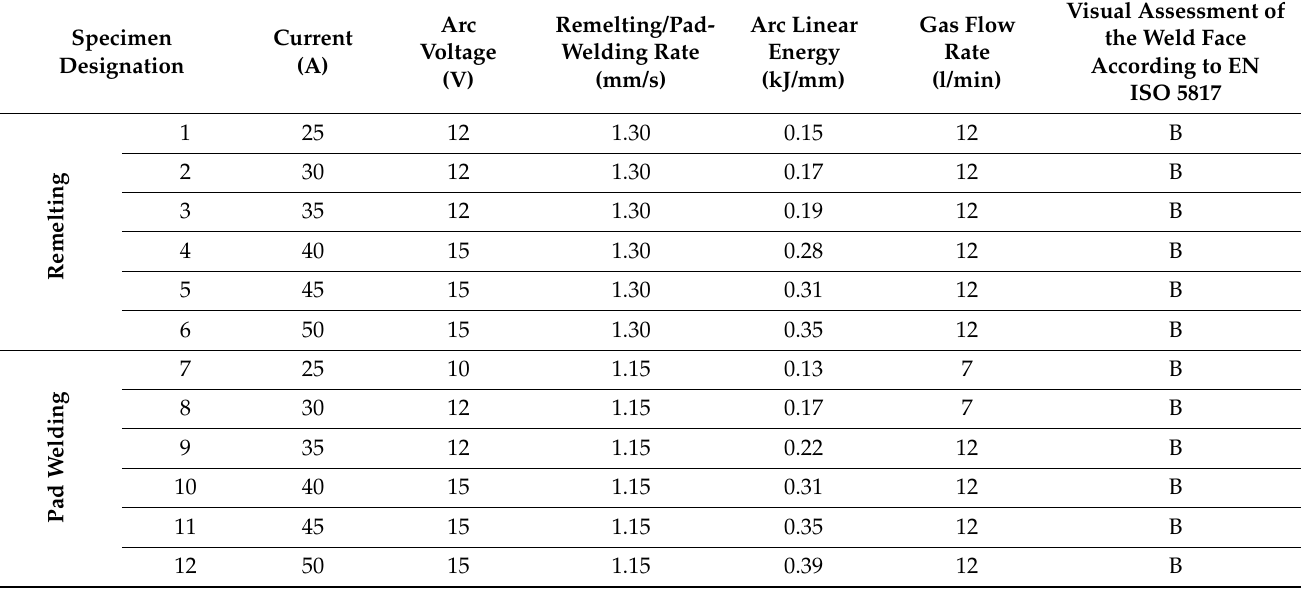
Table 3. Parameters of the TIG remelting and pad-welding processes in a TecLine 8910 gas mixture